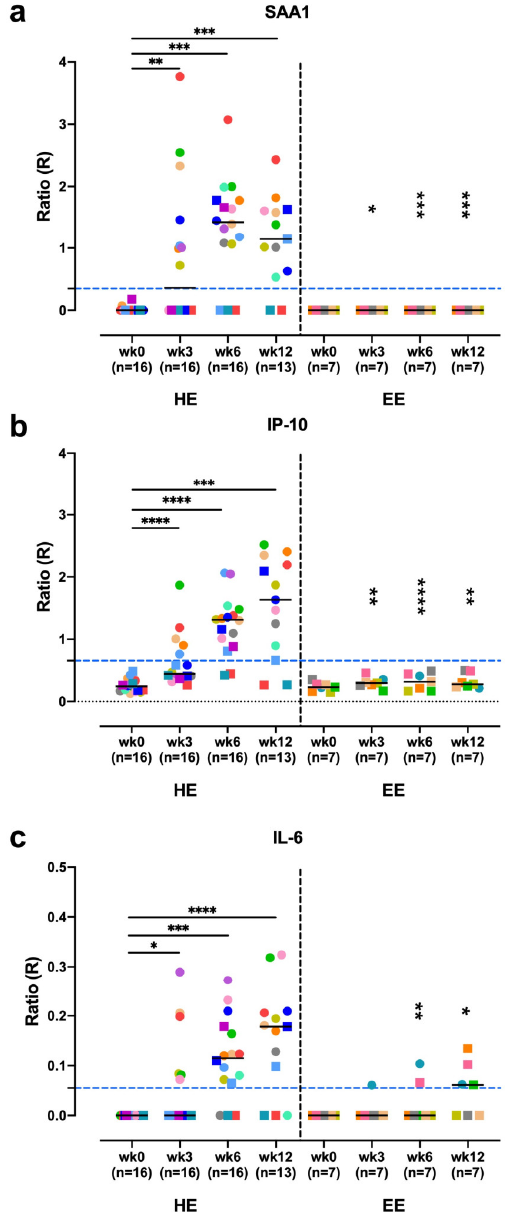
Figure 5. SAA1, IP-10, and IL-6 levels in serum increased after infection and are associated with the disease severity. SAA1, IP-10, and IL-6 levels ( y -axis) were measured by UCP-LFA in serum from high-dose (500 CFU) MTB Erdman infected rhesus macaques ( n = 23), of which 16 animals developed progressive disease and reached a premature humane endpoint (HE), while the endpoint by protocol was fixed at 50 weeks after challenge (EE). The median values of each group are indicated by horizontal lines. Cut-off for positivity (blue dashed lines) as described in Table 1b. Each coloured square (BCG-vaccinated, n = 12) or dot (unvaccinated, n = 11) represents an individual NHP. ( a – c ) SAA1, IP-10, and IL-6 postinfection levels were significantly increased in the humane endpoint (HE) group only. SAA1, IP-10 and IL-6 levels in NHPs with the HE in week 3, 6 ( n = 16) and week 12 ( n = 13) were higher than the EE ( n = 7). Significant differences between each timepoint versus week 0 were determined by Wilcoxon matched-pairs signed rank tests. Since three macaques reached a HE before week 12 in the HE group, only 13 data points are available for week 12. Differences between HE versus EE at per time point were determined by Mann-Whitney U tests indicated in the right panel (EE). p -values: * p < 0.05, ** p < 0.01, *** p < 0.001, **** p < 0.0001.